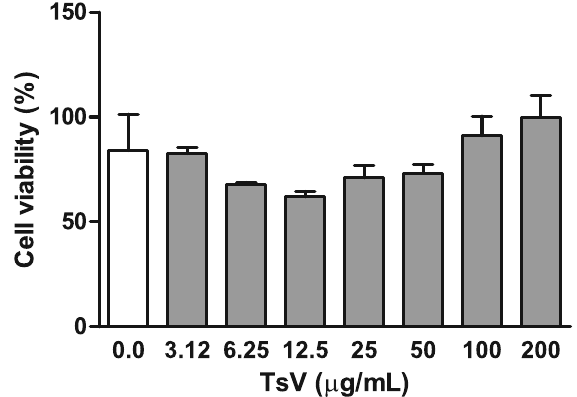
Figure 4 - Effect of Tityus stigmurus venom (TsV) at different concentrations on Madin–Darby Canine Kidney (MDCK) cell viability. Data are expressed as mean ± SEM of three independent experiments and were analyzed by ANOVA followed by Dunnett’s